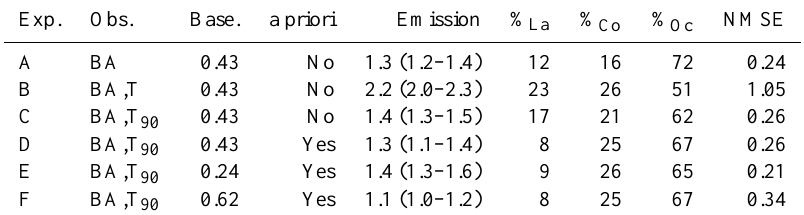
Table 2. A summary of various parameters used in, and results from, inversion experiments A–F. Observational constraint is provided by data collected at the inland site, Bukit Atur (BA), and the coastal location, Tawau (T). The coastal data is sometimes capped at the 90th percentile ( T 90 ). The baseline mixing ratio (units of ppt), and whether an a priori condition of zero emissions from land is employed, is also noted for each experiment. The table also summarises the CHBr 3 emission estimated by each experiment, which are discussed in Sect. 5. Emissions are listed for the “fine” solution grid cells (inside the solid black contour in Fig. 2, and in red/orange in Fig. 3). The grid cell-by-grid cell mean emission magnitude is given, with the range of the 25 separate solutions in parentheses. Emission units are GgCHBr 3 yr − 1 . The percentage of the total emission from land (La), coast (Co) and ocean (Oc) grid cells is also noted, with surface definitions taken from the UM land/sea mask. Finally, the cost function score (Eq. 2) for each experiment is noted. Exp.